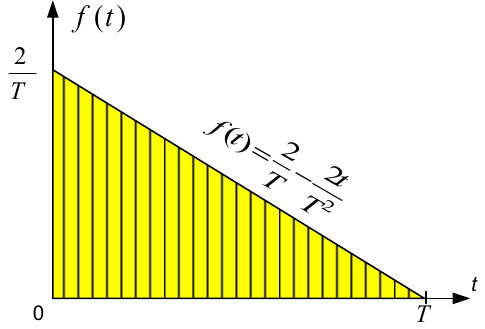
Figure 5. Graph of the PDF of travel time for a random trip in a one-dimensional Figure 5: Graph of the PDF of travel time Figure 4: Area of a cut normal to axis t . for a random trip in a one-dimensional zone.